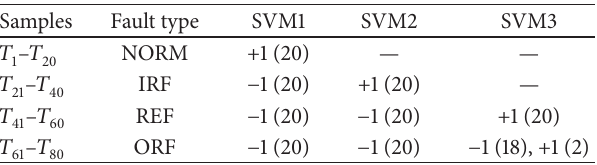
Figure 9: The outputs of BP-classifier with feature vector consisting of the PE when 𝜏 = 1 . Table 3: The outputs of SVM-classifier with feature vector consist- ing of the first five